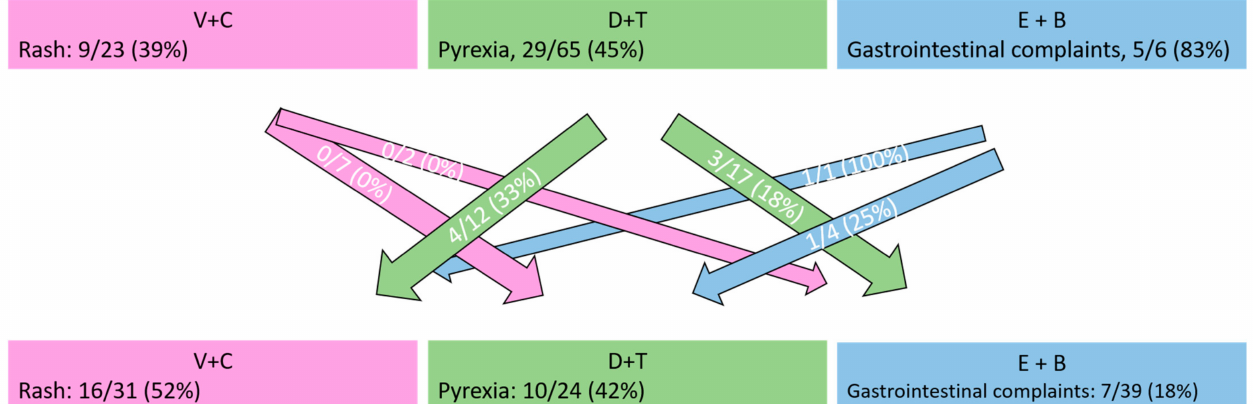
Figure 3. Number of patients suffering from class-specific side effects during the respective BRAF+MEK inhibitor combination (vemurafenib + cobimetinib [V+C], dabrafenib + trametinib [D+T], or encorafenib + binimetinib [E+B]). Numbers in arrows represent the number of patients who expe- rienced the same side effect during the second BRAFi+MEKi combination as well (e.g., 0/7 patients with a rash during V+C also experienced a rash during